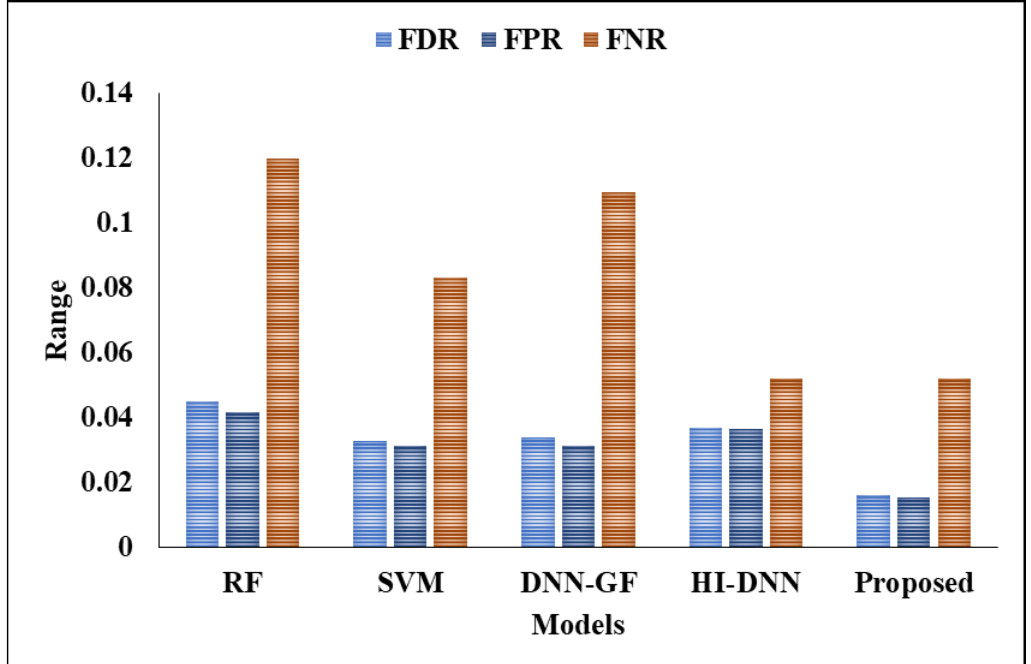
Figure 10. Graphical representation for error analysis.